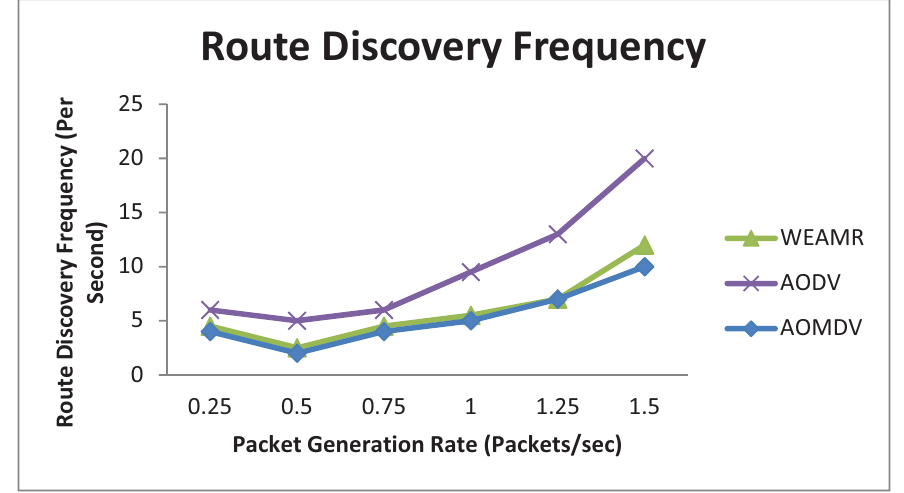
Figure 16. Average Route Discovery frequency with increasing number of packets.